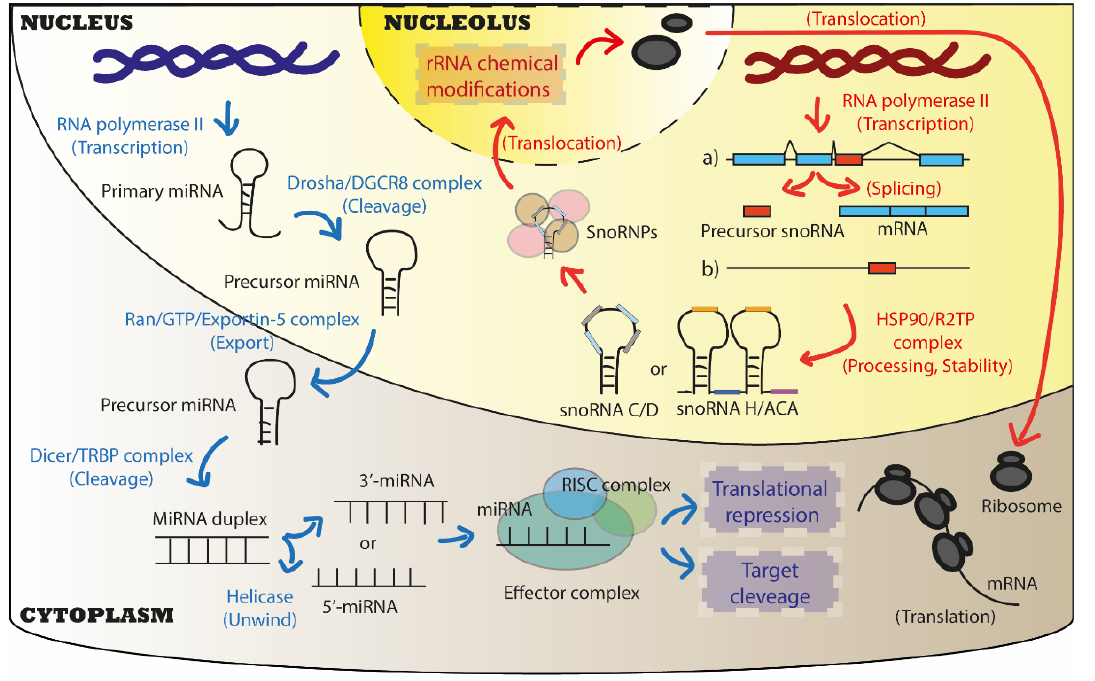
Figure 2. Biogenesis and canonical biological functions of miRNAs and snoRNAs. Both miRNAs and snoRNAs are usually transcribed by the RNA polymerase II (RNA Pol II) in the nucleus of cells. For miRNA biogenesis, two cleavages are requested to obtain a mature miRNA: the first is performed by Drosha/DGCR8 complex in the nucleus, the second by Dicer/TRBP in the cytoplasm. The Ran/GTP/Exportin-5 complex is responsible for the physical translocation of immature miRNAs from the nucleus to the cytoplasm. Finally, one or both strands of the mature miRNA duplex (3 ′ , 5 ′ filaments) can interact with the RISC complex to form the effector complex that exerts its biological functions in the cytoplasm mainly. Canonical functions of miRNAs are to act as translational repressor by promoting the cleavage of targets or inhibiting their translation. For snoRNA biogenesis, after transcription from genomic intron regions (the most common pathway), or as independent transcripts, snoRNA precursors are processed and stabilised by the HSP90/R2TP complex into mature snoRNAs that usually belong to two main classes: Box C/D and box H/ACA snoRNAs. Once associated with core proteins to form snoRNPs, mature snoRNAs then translocate into a sub-compartment of the nucleus, the nucleolus, where they exert their biological functions. Canonical functions of snoRNAs are to promote chemical modifications on ribosomal RNAs (rRNAs), which directly impacts ribosome function during mRNA translation.